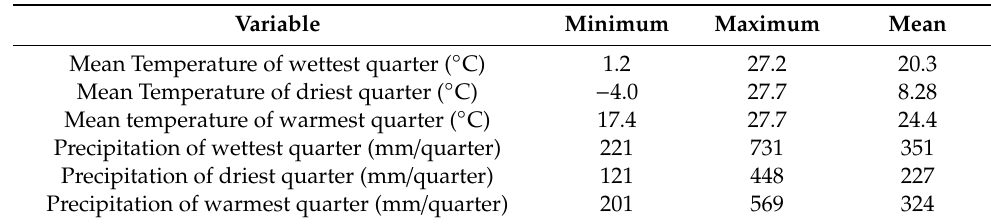
Table 2. The bioclimatic profile which includes minimum, maximum, and mean of the selected bioclimatic factors for T. c. carolina occurrence